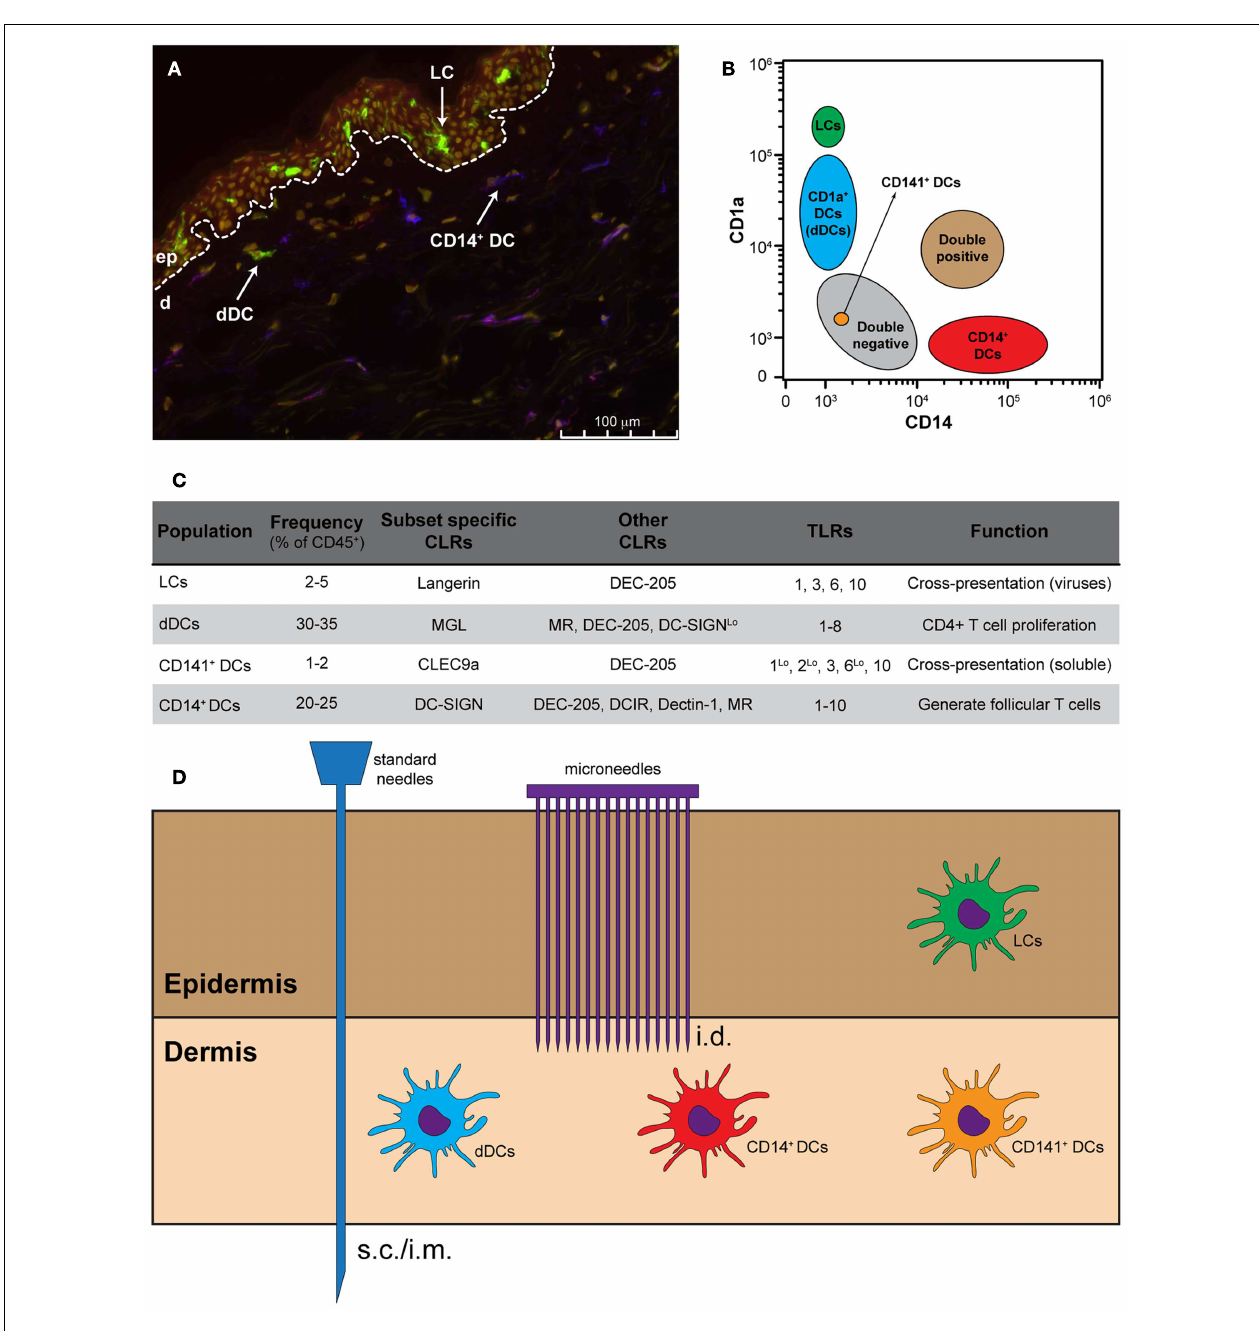
CD14 expression levels. (C) Frequency, CLR andTLR expression and function of the four main skin APC subsets. (D) Standard needles do not allow skin APC targeting, while different models of microneedles allow for the specific targeting of dermal APCs and, in some cases, also LCs.